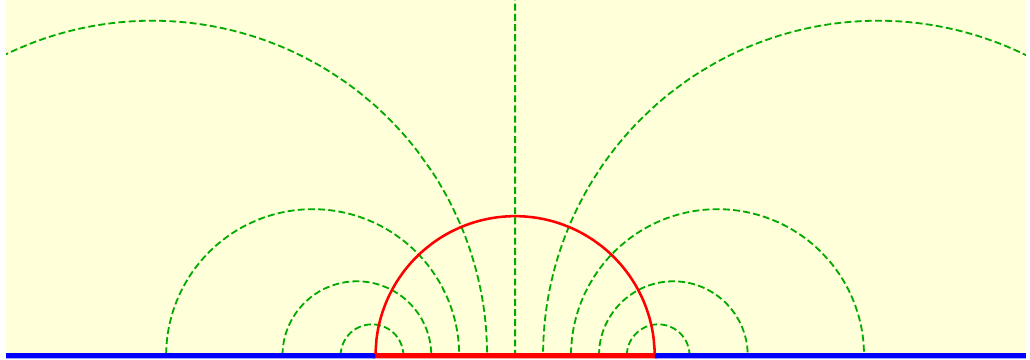
Figure 3 . Geodesic bit threads (green dashed curves) in a fixed time slice of Poincaré AdS 3 (yellow region) associated to an interval on the line (red segment), whose RT curve is the red solid half circle anchored to its